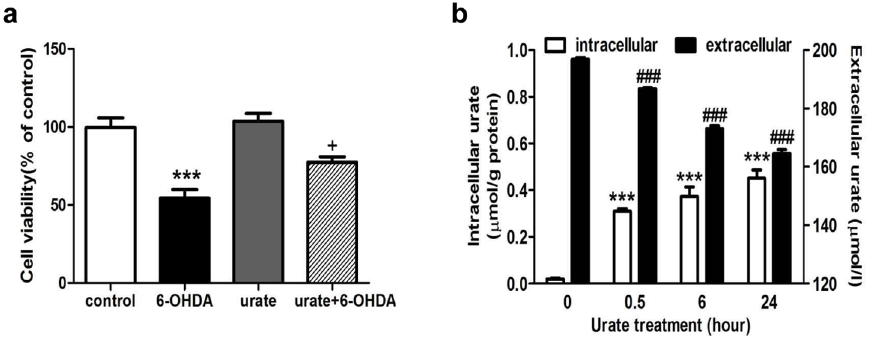
Figure 2. Urate was accumulated into SH-SY5Y cells and exerted protection intracellularly. ( a ) Effect of urate pre-treatment on cell viability. Urate was removed by washout after 30 min pre-incubation, followed by 6-OHDA treatment for 14 h. ( b ) Accumulation of urate into SH- SY5Y cells as incubation time increased. Cells were treated with 200 m mol/l urate for different time periods as indicated. The extracellular and intracellular urate content was determined as described in ‘‘Material and methods’’. The intracellular urate level was normalized by the protein concentration. Results were shown as Mean 6 SEM, n=3. + P , 0.05 versus 6-OHDA group; *** P , 0.001 versus controls or intracellular value of controls (0 h); ### P , 0.001 versus extracellular value of controls (0 h).